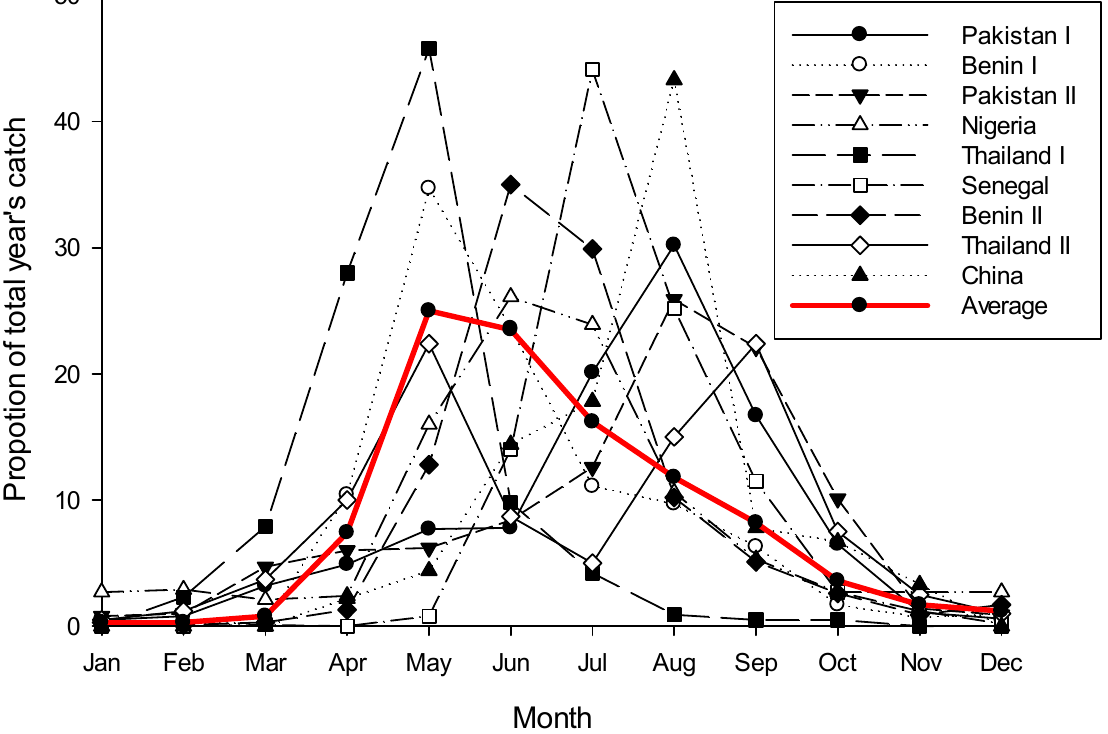
Figure 2. Yearly phenology curves for Bactrocera dorsalis for nine sites across the northern hemisphere, plus the average plot of those nine. Data for plots was read from tables or graphs in the source papers and then transformed as a proportion of the total year’s catch for that site. Variance data from the original sources is not included, and where data had to be read from graphs exact values are not guaranteed. Sources [106–113]; these sources were selected simply for the ease by which their data could be read.